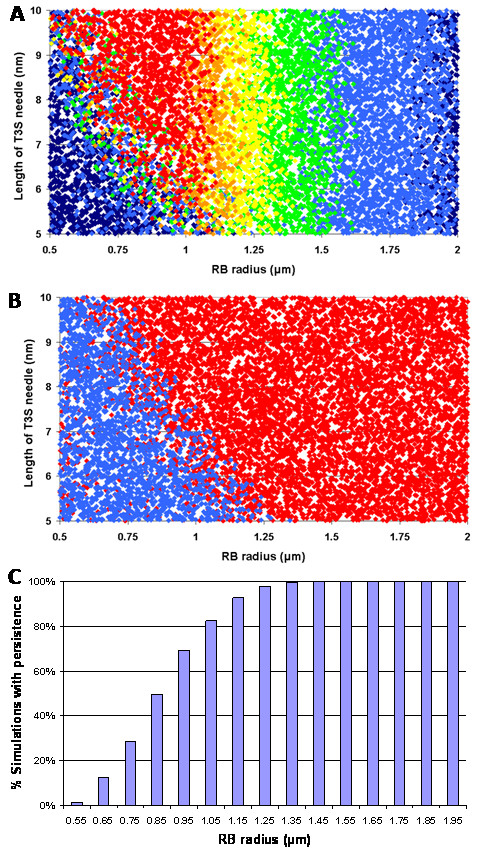
Scatterplot from 10,000 stochastic model time course simulations of the length of T3S needle versus the RB radius, color-coded (a) for the maximum number of RBs, RBmax: dark blue RBmax < 20, light blue 20 ≤ RBmax < 40, green 40 ≤ RBmax < 60, yellow 60 ≤ RBmax < 80, orange 80 ≤ RBmax < 100, and red RBmax > 100; (b) by whether normal (blue) or interrupted (red) development, leading to persistent infection occurred. (c) Histogram summarizing 10,000 simulations of persistence or normal development, grouped by the size of RB radius; groupings are in intervals of 0.1 μm and the mid-point of the interval is shown.